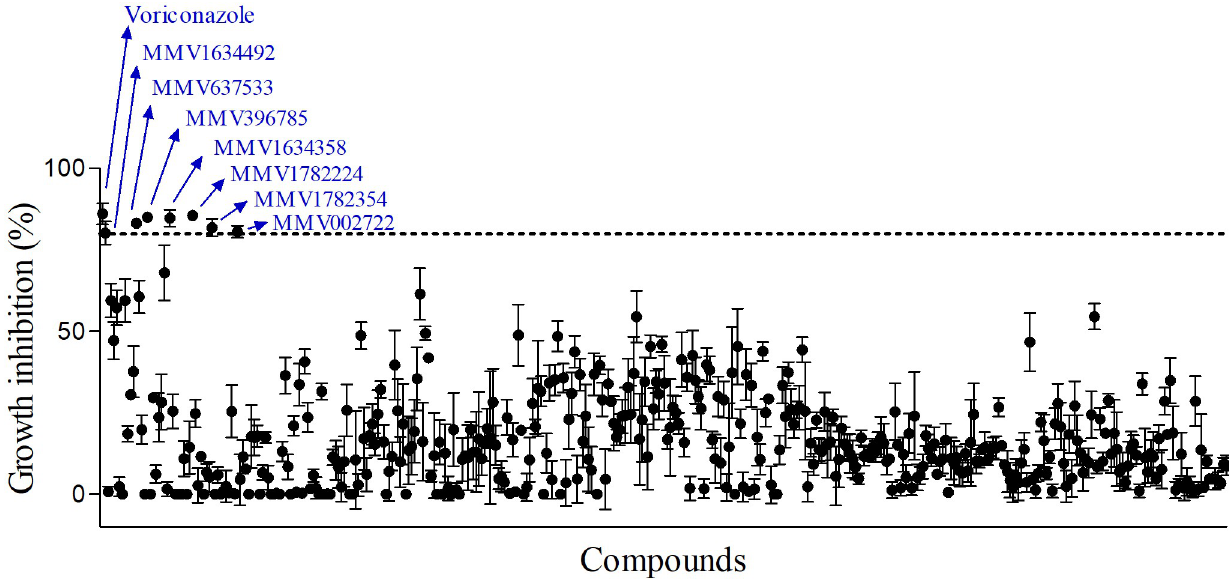
Fig 1. Screening of the Pandemic Response Box 1 library. A total of 400 compounds were tested against S . aurantiacum CBS 136046. Fungal growth was quantified after incubation for 72 h by optical density and those presenting at least 80% of inhibition (dotted line) were selected. Voriconazole was used as positive control of inhibition. Experiments were performed in quadruplicate, in three independent experimental sets.